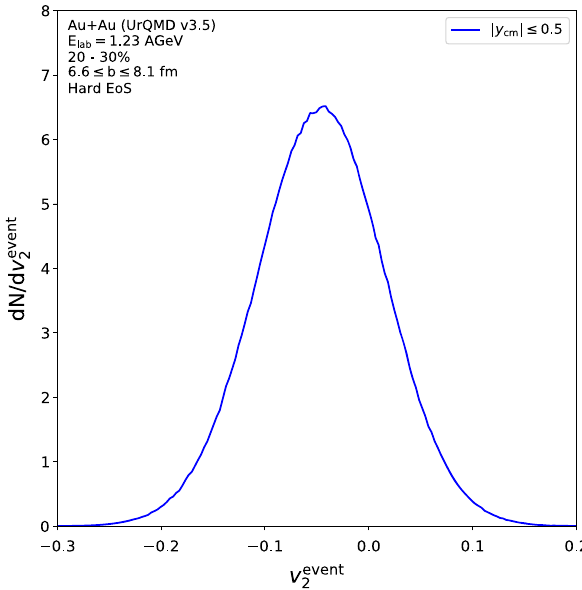
Fig. 1 The v 2 distribution integrated over all nucleons in the rapidity window | y cm |≤ 0 . 5 in 20–30% central Au+Au collisions at kinetic beam energy of 1.23 AGeV from UrQMD with a hard EoS